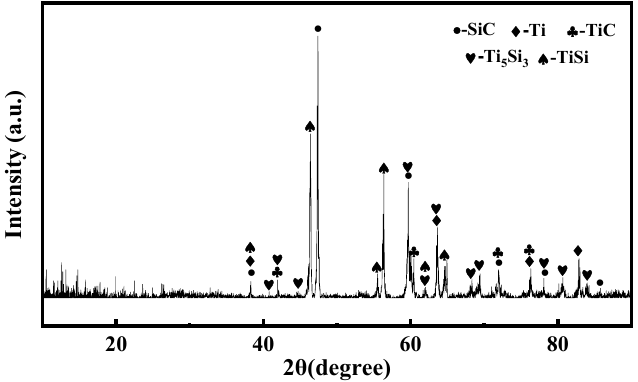
Figure 7. X-ray diffraction (XRD) spectrum of the composite layer.